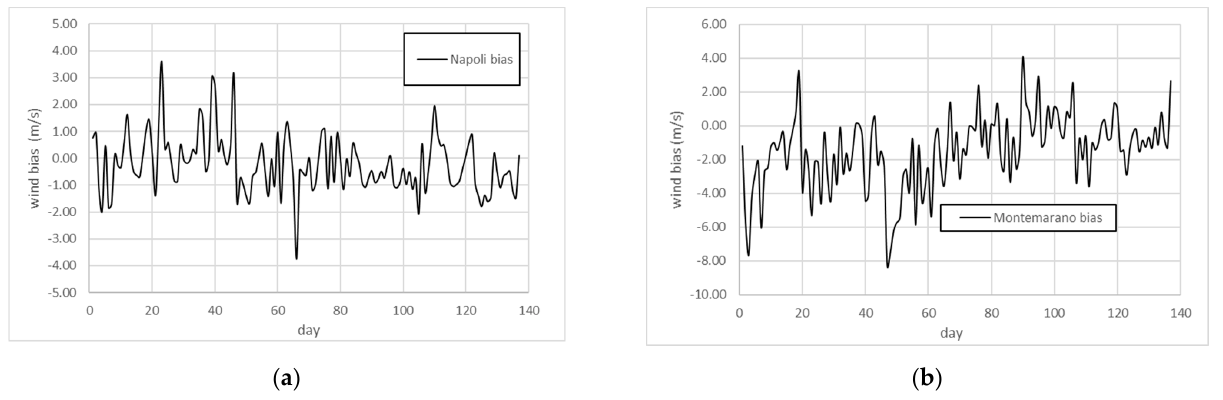
Figure 10. Time series of daily wind speed bias values (m/s) against station data in Napoli Capodichino ( a ) and Mon- temarano ( b ) at 10 m, over the considered period. Model data are related to the nearest grid point.